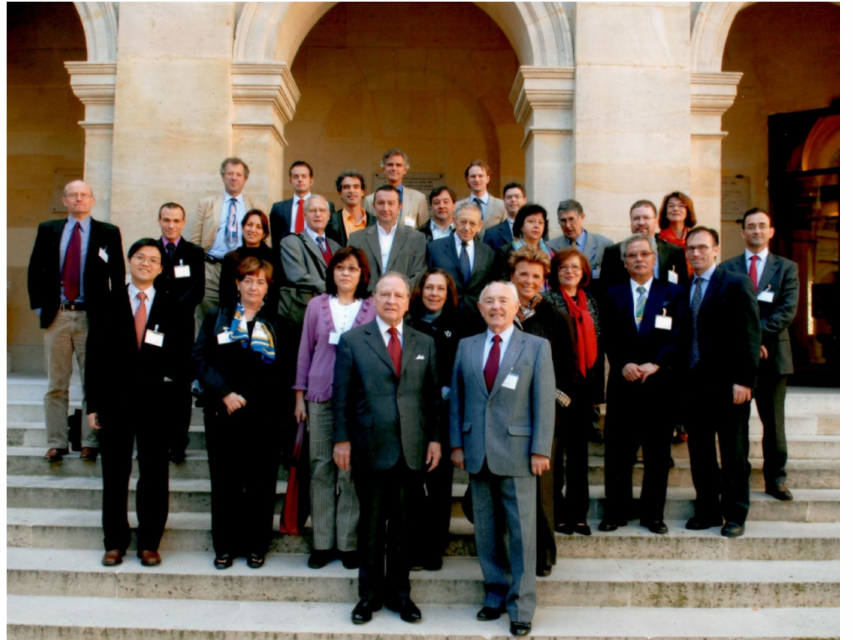
Figure 2. A group photo of international research colleagues and Dr. Cotrel (right on the first row) taken during 2007 Cotrel Foundation Annual Scientific meeting (courtesy of the Cotrel Foundation).